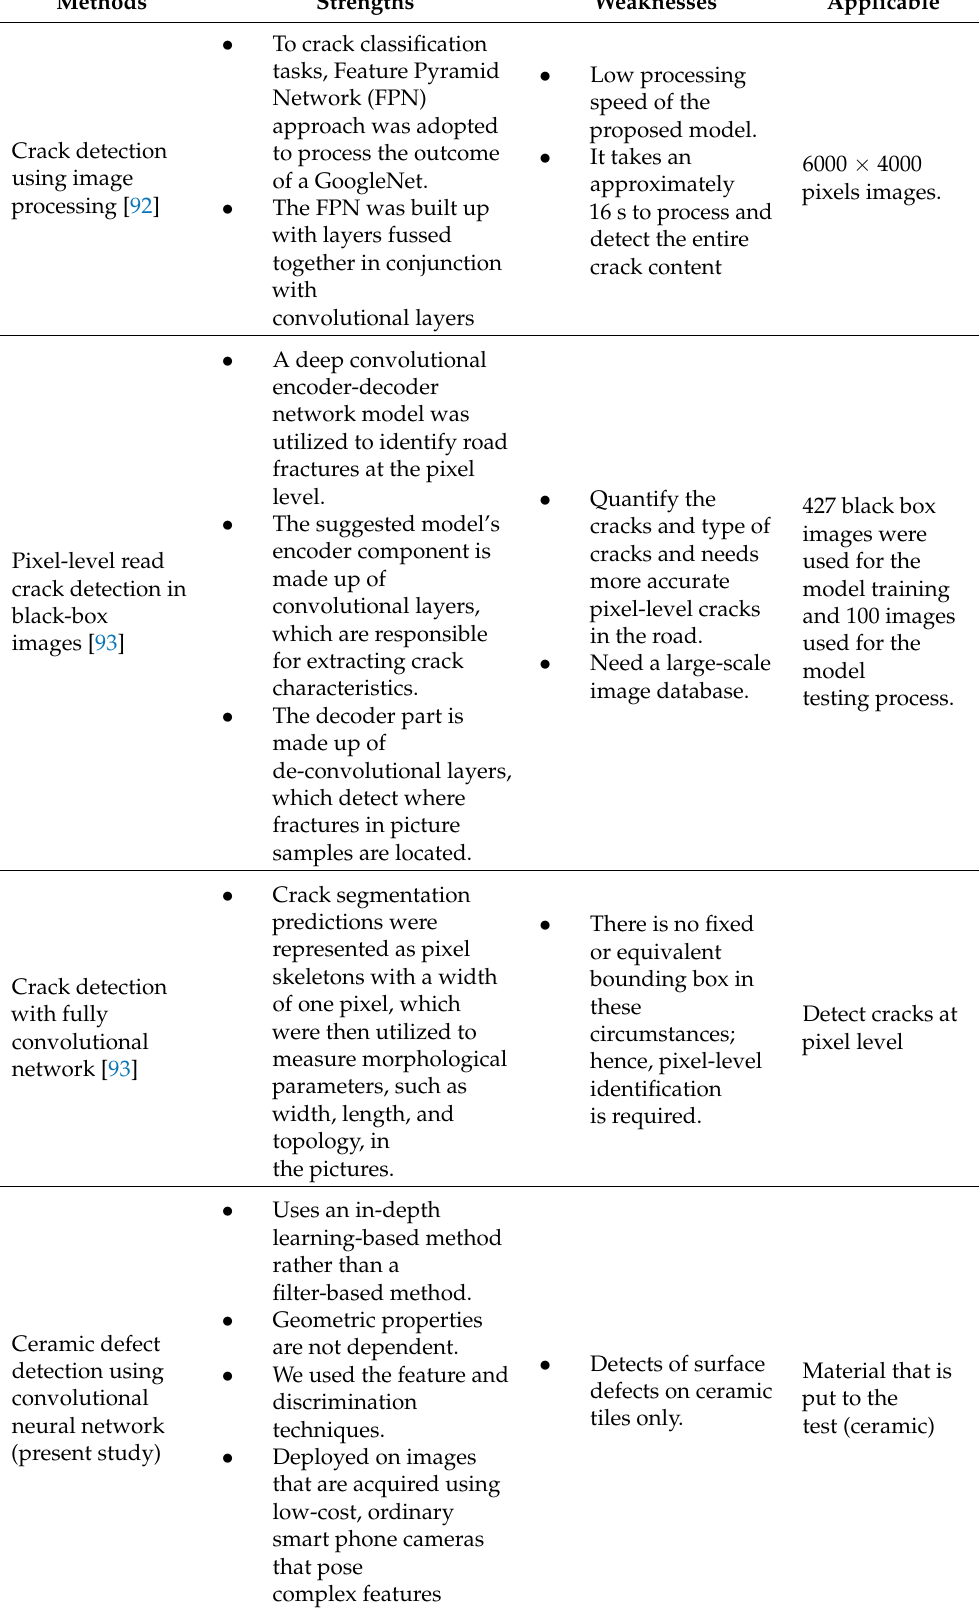
Table 4. Comparative performances of deep learning-based crack-detection